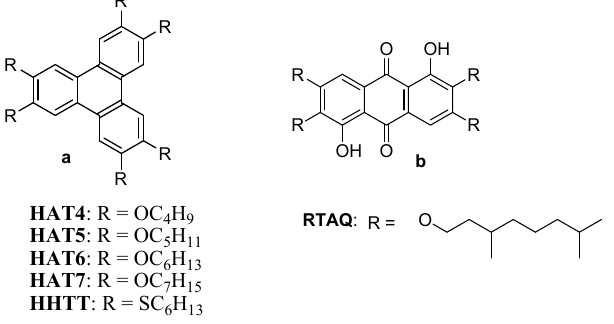
Figure 2. Molecular structures of commonly used triphenylene ( a ) and anthraquinone ( b ) based discotic liquid